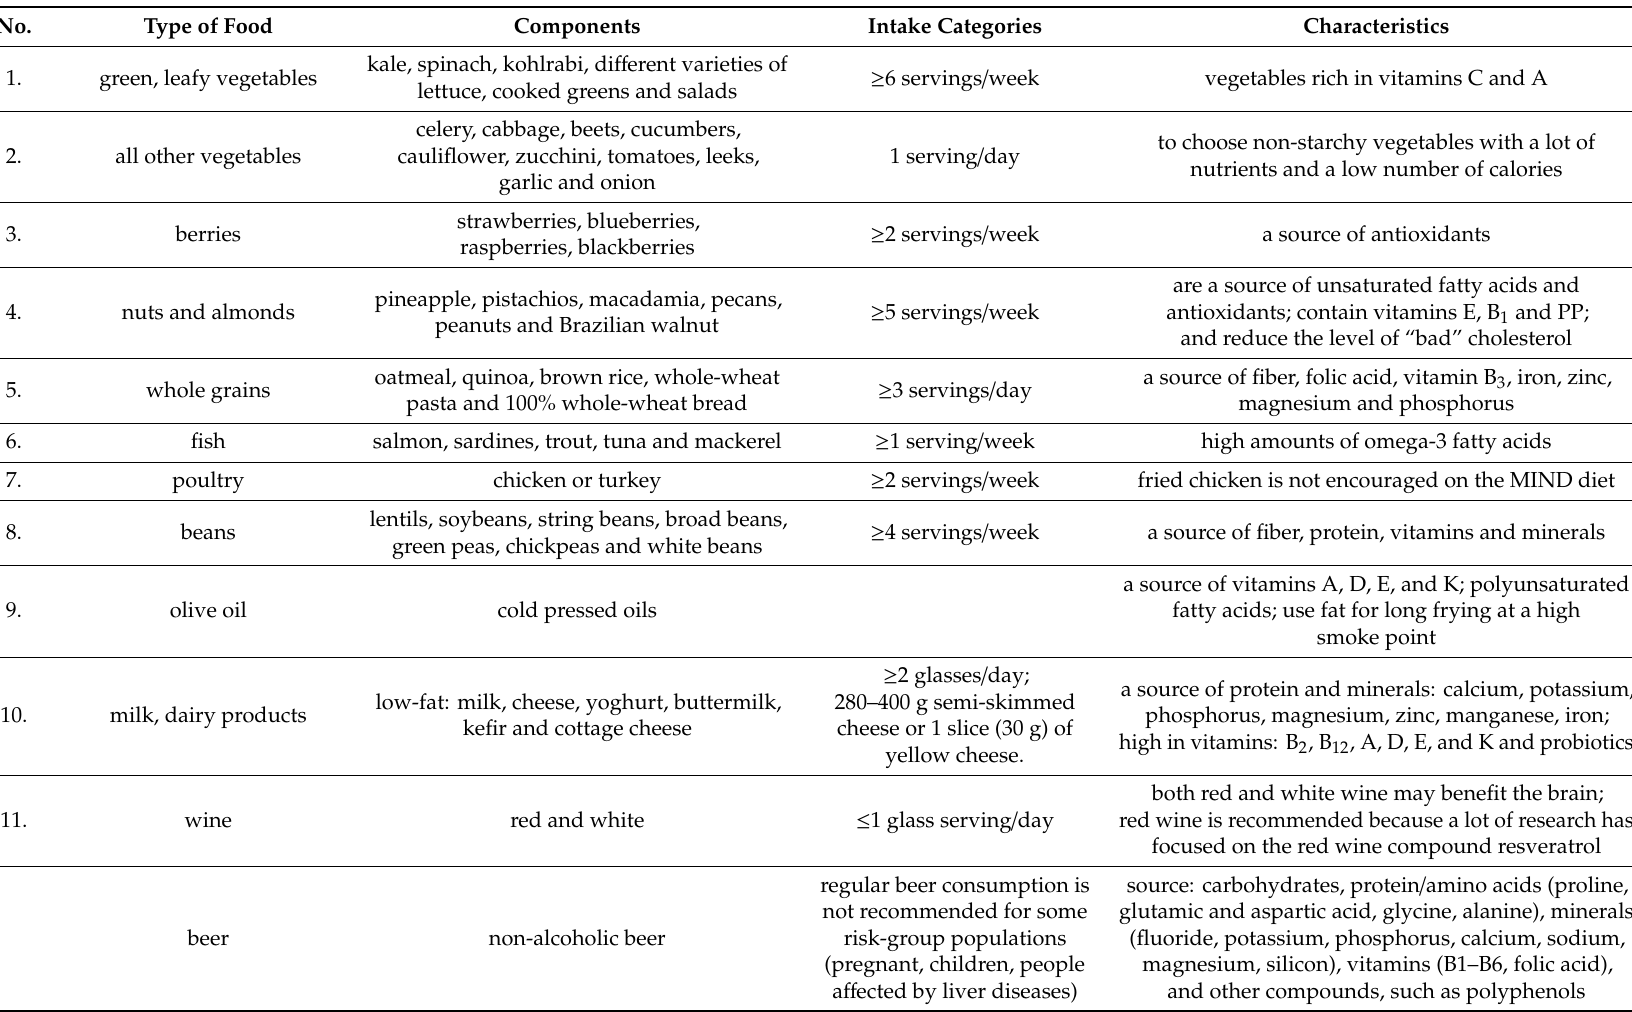
Table 1. Type and frequency of consumption of foods in the Mediterranean-DASH Intervention for Neurodegenerative Delay (MIND) diet pattern with a role in Alzheimer’s prevention [26,48],